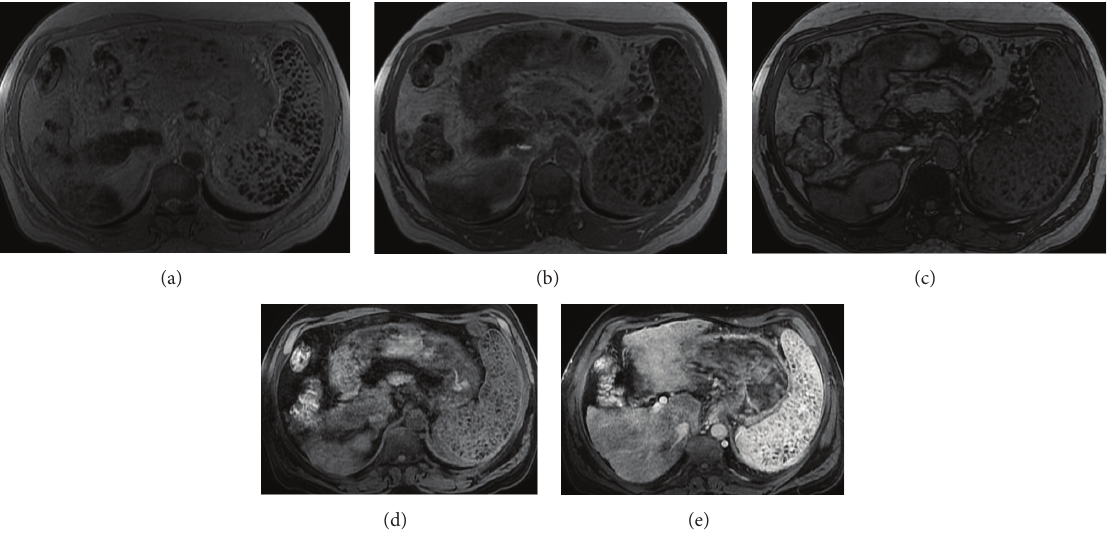
Figure 20: Siderotic splenic nodules (Gamma-Gandy bodies). Axial T2 ∗ (a), axial 2D-GRE T1w in-phase (b) and out-of-phase (c), and pre (d) and postcontrast axial 3D-GRE T1wi with fat suppression at the arterial phase (e). Note the splenomegaly with multiple foci of hemosiderin with low signal intensity on all pulse sequences and exhibiting the “blooming” artifact on in-phase (longer TE) GRE sequences, secondary to iron deposition. No enhancement is depicted.